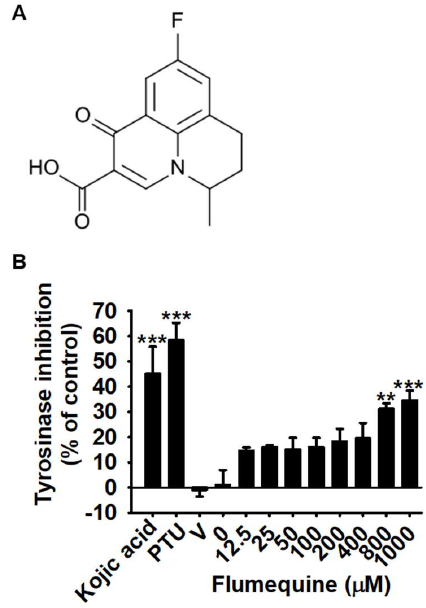
Figure 1. Flumequine slightly upregulates mushroom tyrosinase activity in vitro at high concentrations. ( A ) Chemical structure of flumequine. ( B ) The e ff ect of flumequine on in vitro mushroom tyrosinase activity. Tyrosinase activity was determined by oxidation of L-DOPA as a substrate. Briefly, flumequine (0–1000 µ M), kojic acid (25 µ M), and phenylthiourea (PTU) (250 nM) were loaded into a